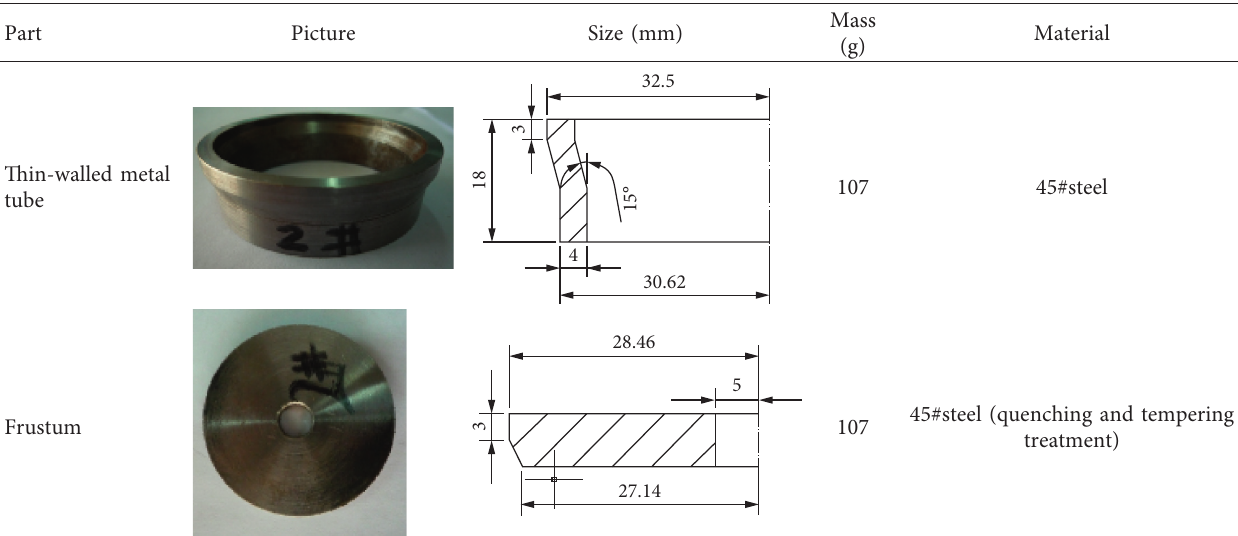
Table 2: Structural parameters of buffer No.